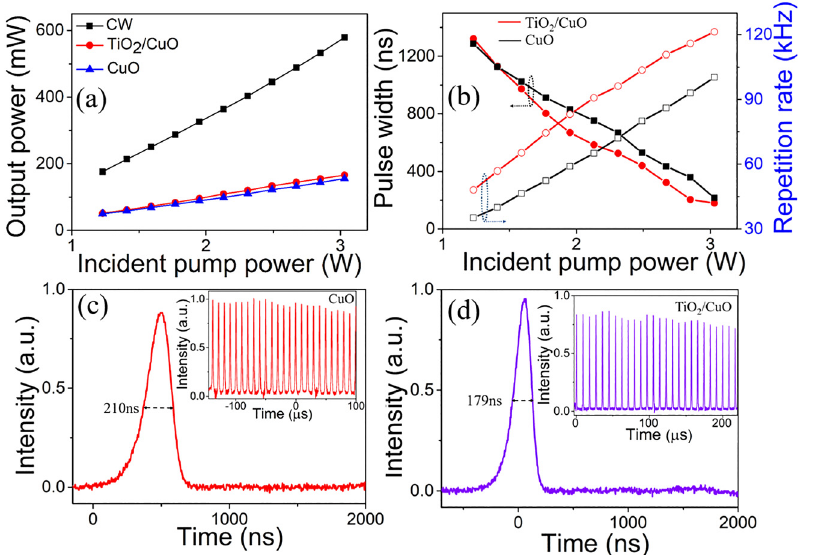
Figure 7: Experimental performances of the passively Q-switched (PQS) lasers with cupric oxide (CuO) and TiO 2 /CuO nano- composites at 1.87 μ m. (a) Continuous wave (CW) and Q-switched average output power. (b) Pulse width and repetition rate versus the incident pump power. (c), (d) Typical Q-switched temporal pulse profile and trains of CuO and TiO 2 /CuO lasers, respectively.